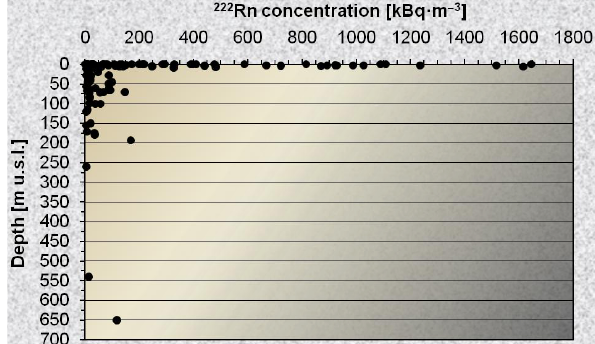
Fig. 4. Correlation between 222 Rn activity concentration and the depth of groundwater intake for the 111 selected intakes from the area of the Sudetes (SW Poland) (according to Przylibski,